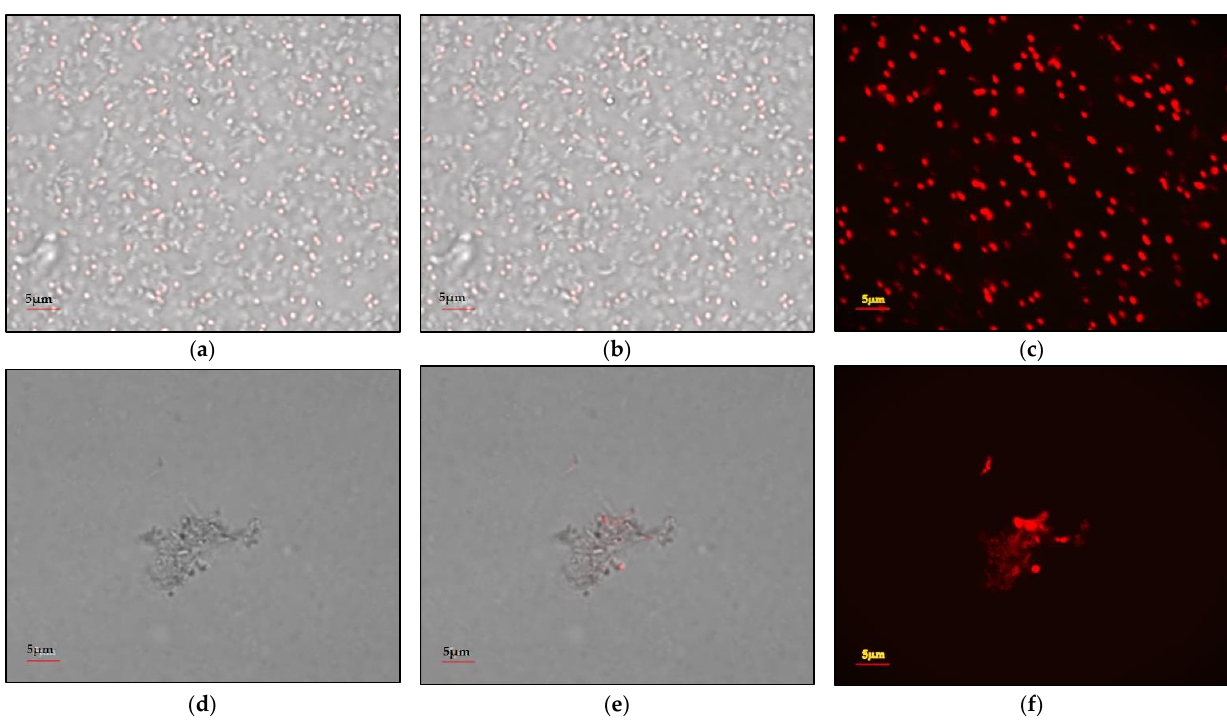
Figure 1. Effect of the herb extract on Yersinia enterocolitica , analyzed using confocal microscopy. ( a – c ) Control sample ( Yersinia enterocolitica ); ( d – f ) Yersinia enterocolitica sample, treated with the ethanolic extract of P. kurroa